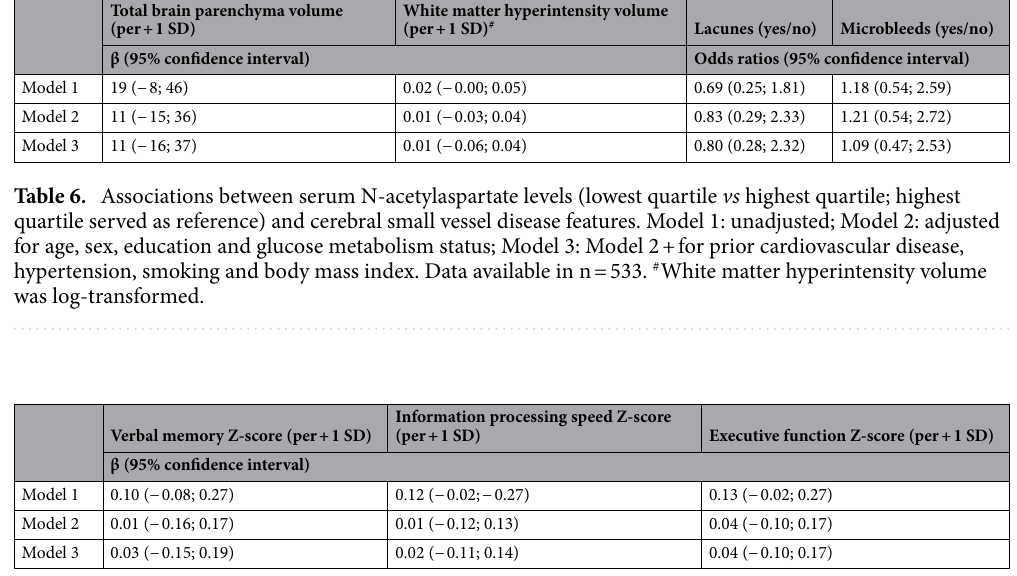
Table 7. Associations between serum N-acetylaspartate levels (lowest quartile vs highest quartile; highest quartile served as reference) and domain-specific cognitive performance. Model 1: unadjusted; Model 2: adjusted for age, sex, education and glucose metabolism status; Model 3: additionally adjusted for prior cardiovascular disease, hypertension, smoking and body mass index. Data available in n =